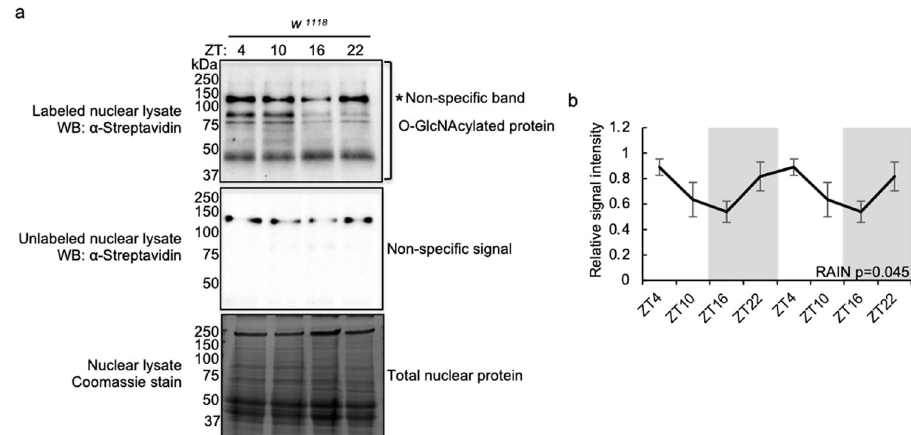
Fig. 1 Protein O-GlcNAcylation oscillates over a 24-h day-night cycle under ad libtum condition. a Western blots showing daily rhythms in O- GlcNAcylation of nuclear proteins extracted from body tissues of wild type ( w 1118 ) fl ies fed ad libtum . O-GlcNAcylation is detected using chemoenzymatic labeling in combination with Western blotting using α -streptavidin. Unlabeled samples (middle panel) were processed in parallel to labeled samples (top panel) to identify non-speci fi c signal. Total nuclear proteins were stained using Coomassie blue (bottom panel) and were used for normalization. The asterisk (top panel) denotes non-speci fi c signal. Each biological replication was performed independently with similar results ( n = 4). b Quanti fi cation of nuclear protein O-GlcNAcylation in ( a ). Data are double plotted and presented as mean ± SEM ( n = 4; p = 0.045; RAIN). α -streptavidin signal of the whole lane was quanti fi ed, and the non-speci fi c signal was used for background deduction prior to normalization. Data are double plotted and presented as mean ± SEM. The grey shading indicates the dark phase of each 12 h light:12 h dark (LD) cycle. ZT Zeitgeber time (hr). ZT0 denotes lights-on